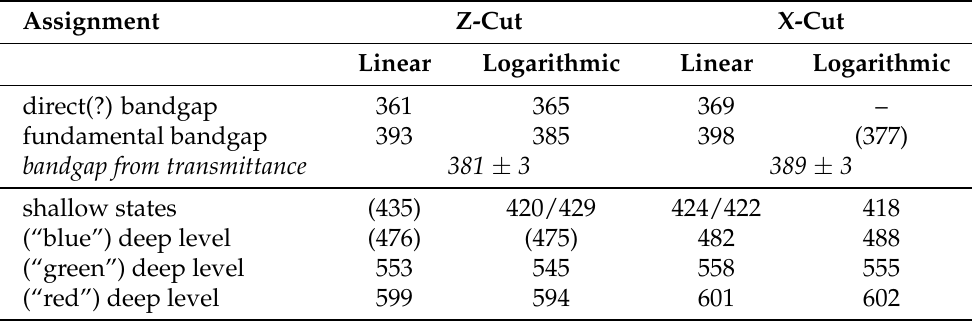
Table 2. Summary of energetic positions (all numbers in nanometers) of spectral features as extracted from the resistance-vs.-wavelength plots of Figure 2 and Figure S4. Numbers in brackets refer to plateaus, all other numbers to points of slope change. Whenever two values are given, two different partial spectra were compared in order to asses the typical error range. For comparison, the bandgap values from the transmittance measurements were added as well (cf. Figure